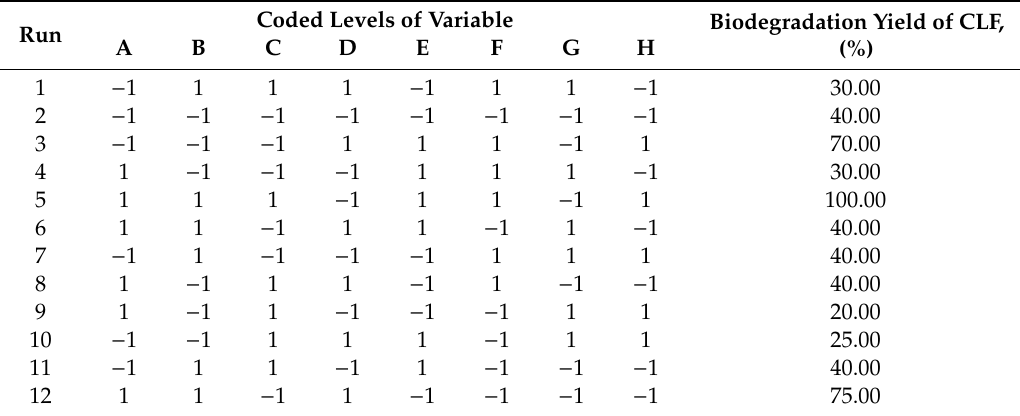
Table 3. The PBD matrix for evaluating of biotechnological factors whit influence on CLF biodegradation by Trametes pubescens selected